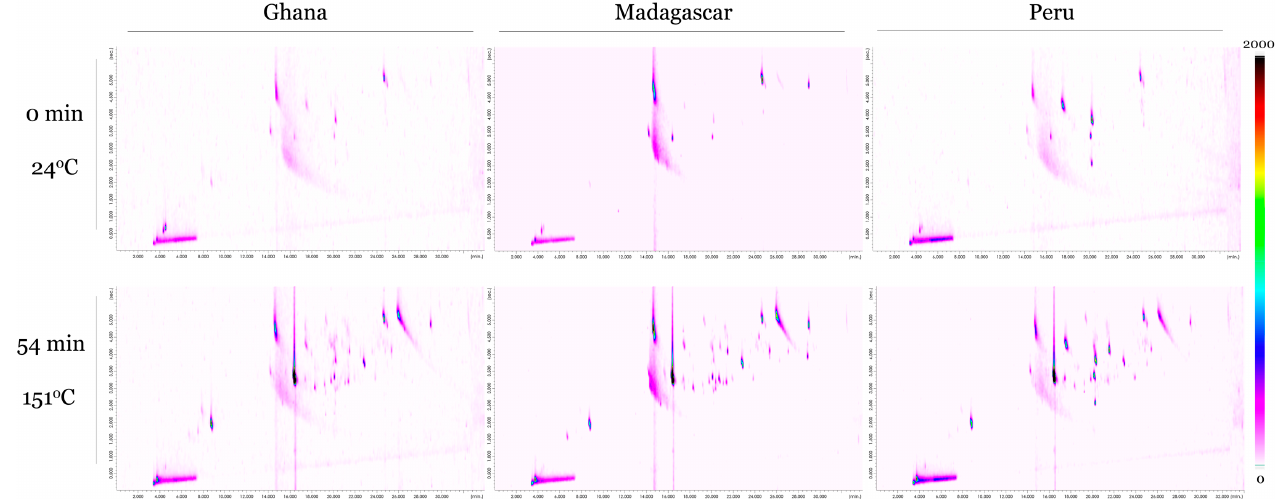
Figure 1. Comprehensive GCxGC-SCD chromatograms for ( top ) unroasted (0 min, 24 ◦ C) and ( bottom ) highly roasted (54 min, 151 ◦ C) chocolate samples for the three cacao origins (Ghana, Madagascar, Peru). All chromatograms are scaled the same to allow for direct comparison (0 to 2000 a.u.).